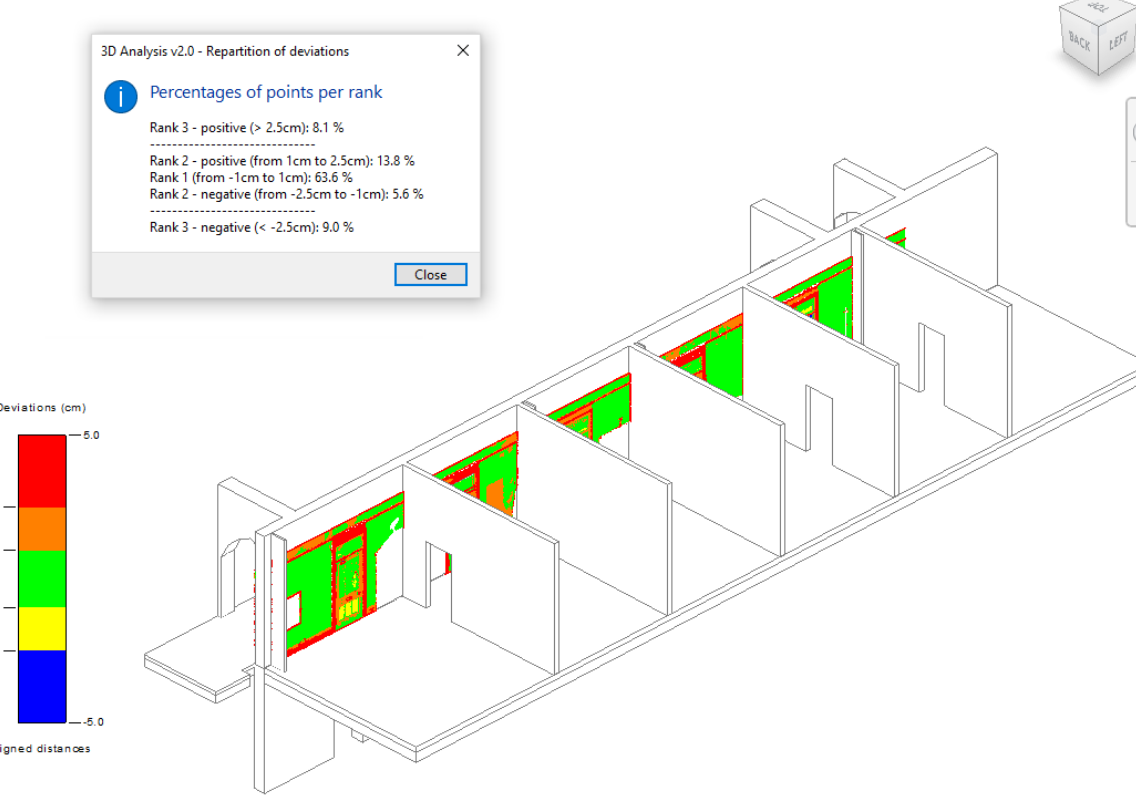
Figure 4: Result of the 3D Analysis